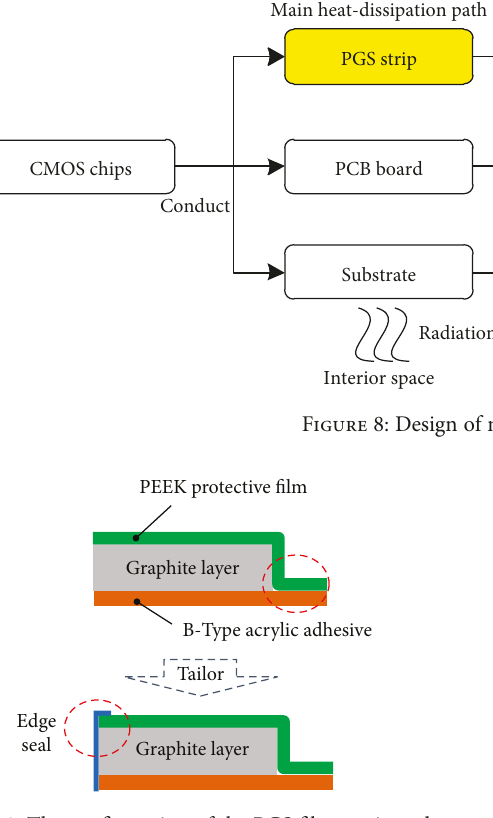
Figure 9: The con fi guration of the PGS fi lm cutting edge.